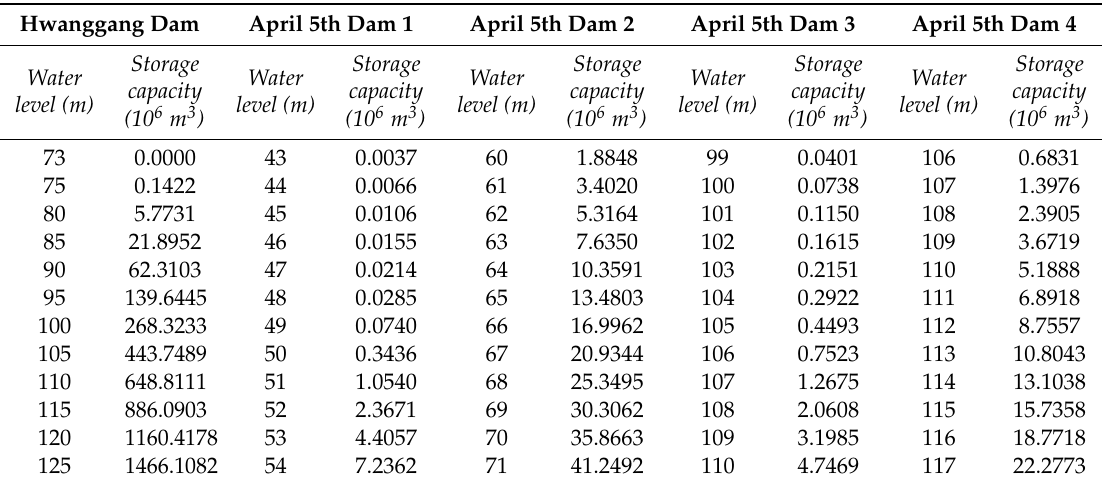
Table 3. Estimation of parameters for 5 dams in the Northern part of the Imjin river